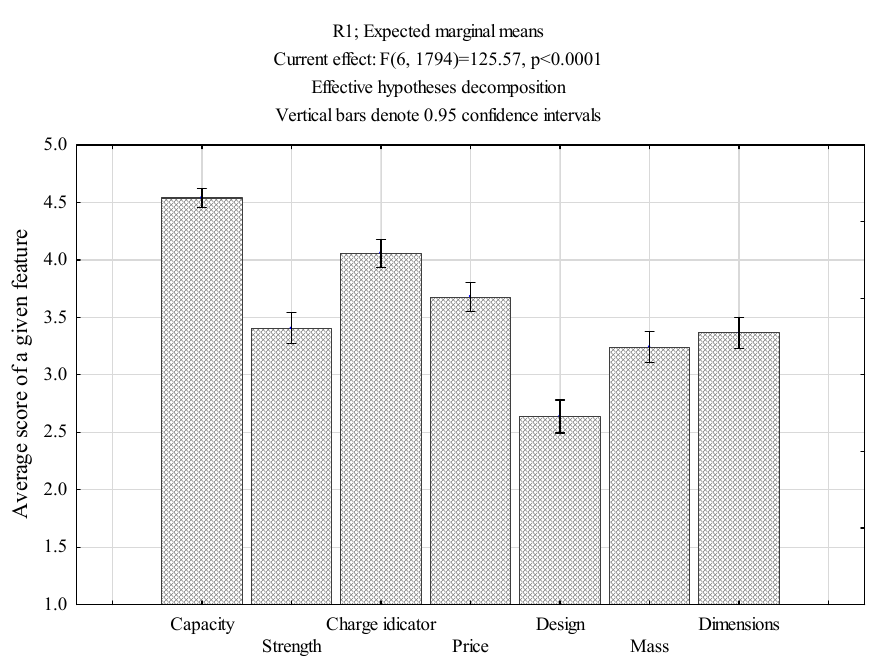
Figure 1. The most important features of a good power bank as indicated by respondents.